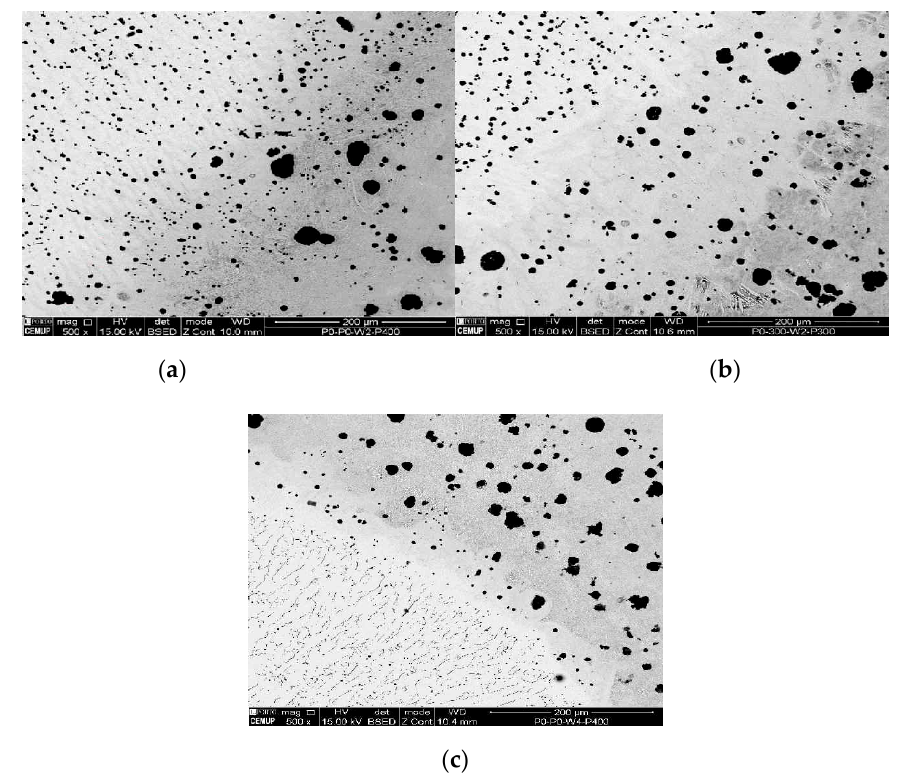
Figure 4. Scanning electron microscopy (SEM) analysis of the experimental samples etched with 4% Nital and 500× magnification: ( a ) sample 1P0W2P400 (UTS 390.0 MPa), ( b ) sample 2P300W2P300 (UTS 394.2 MPa), and ( c ) sample 1P0W4P400 (UTS 394.0 MPa).